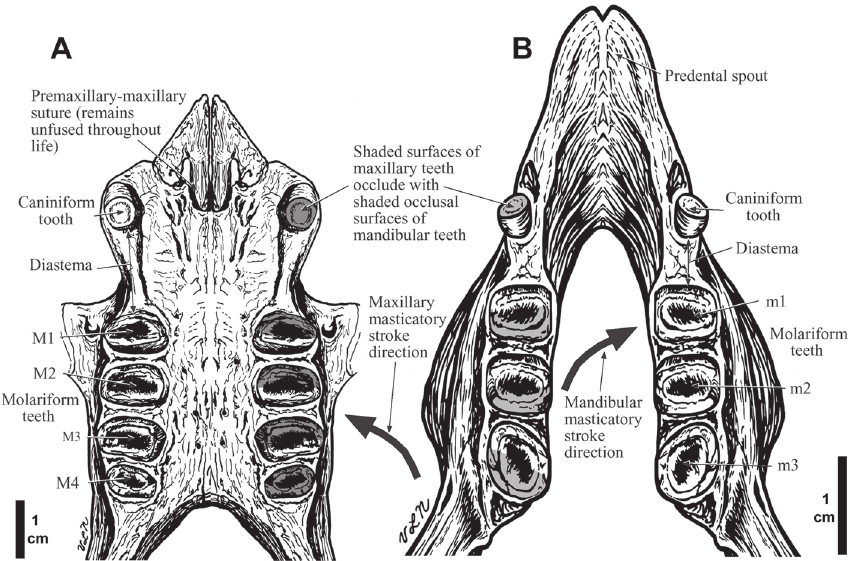
Figure 4. The maxillary ( A ) and mandibular ( B ) dentitions of Hapalops are shown. The shaded and unshaded surfaces of maxillary teeth occlude with corresponding surfaces of mandibular teeth. Arrows indicate the orientation of the masticatory power stroke which emphasizes the mediolateral component of mandibular